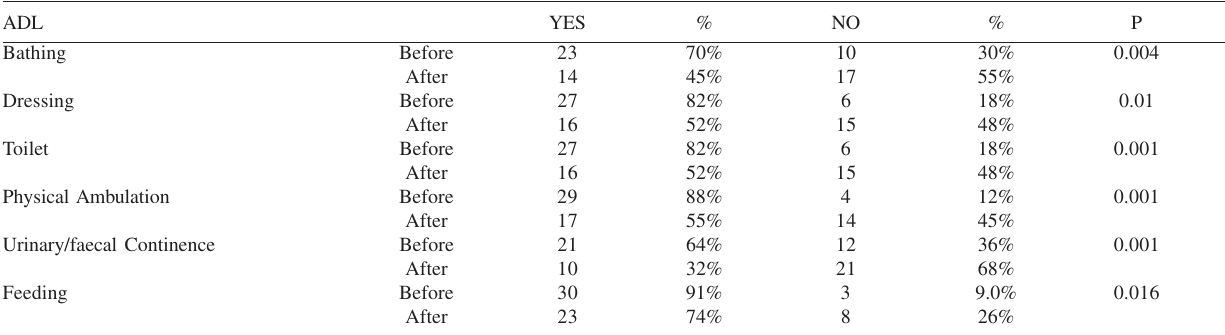
Table 5 - ADL in patients before and after hip fracture ADL